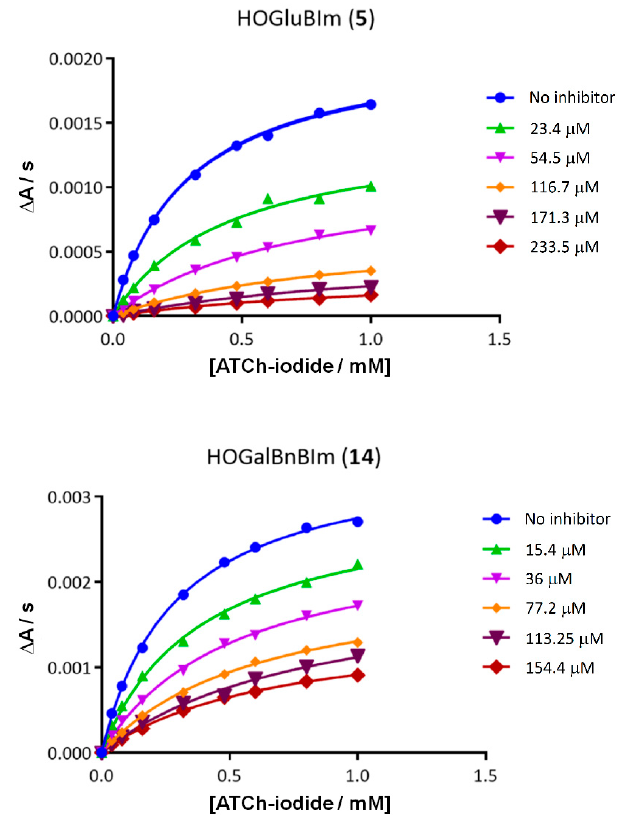
Figure 2. Concentration-dependent inhibition of horse serum butyrylcholinesterase (BChE) by glucoconjugate 5 and galactoconjugate 14 . The graphs represent the inhibition of BChE activity at different concentrations of acetylthiocholine as a substrate. Nonlinear regression analysis was used to determine the inhibition constant ( K i ) and parameter α by Equation (1).